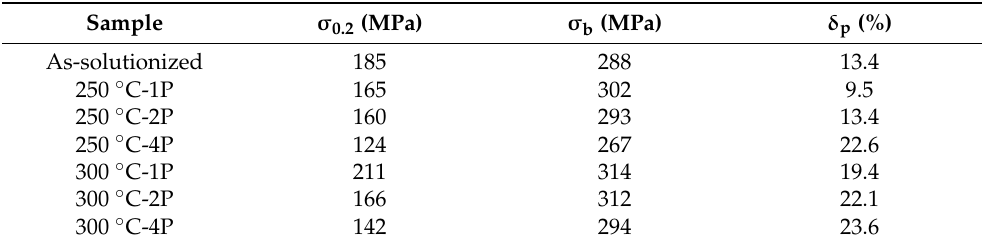
Table 2. Room temperature tensile properties of samples deformed at 250 ◦ C and 300 ◦